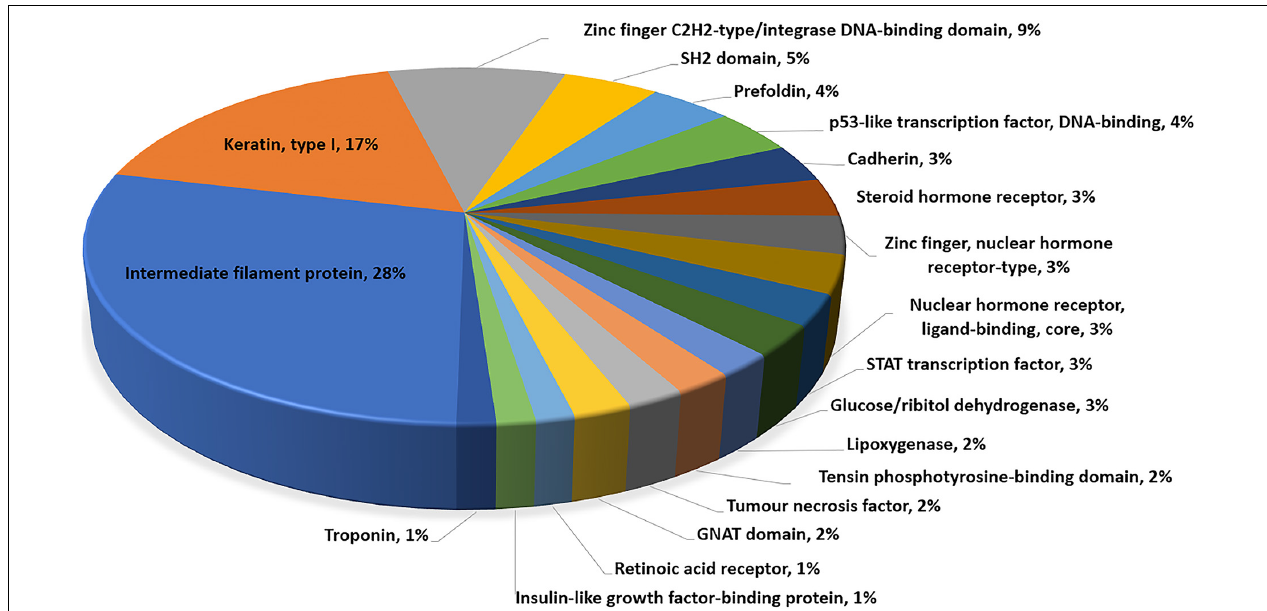
FIGURE 2 | Molecular function analysis of genes located within pleiotropic regions for carcass quality, sensory meat quality, and visual meat quality in a multibreed Angus–Brahman population.